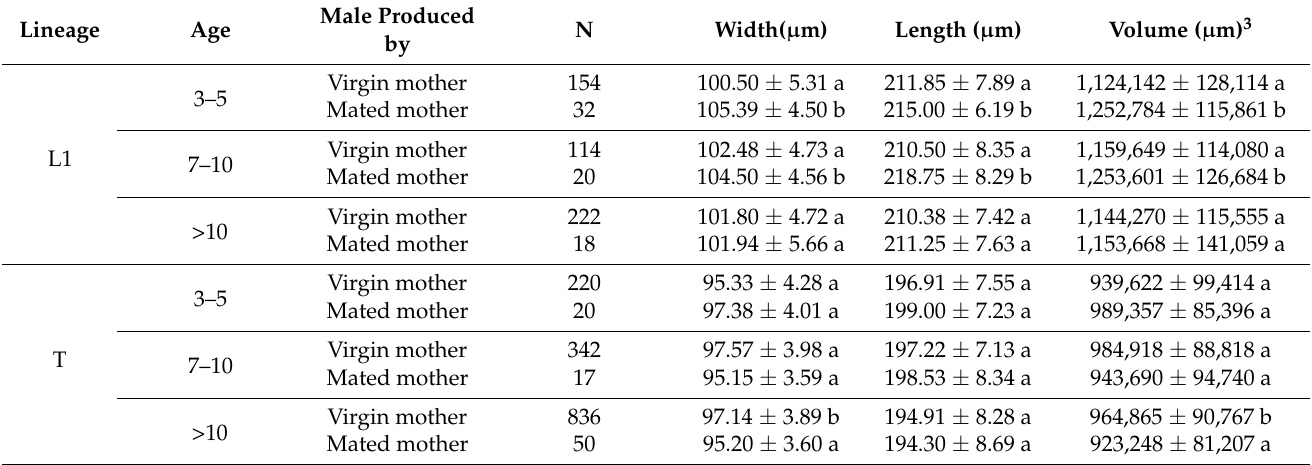
Table 7. Size of male eggs produced by virgin and mated mothers of the L1 and T lineages in different age